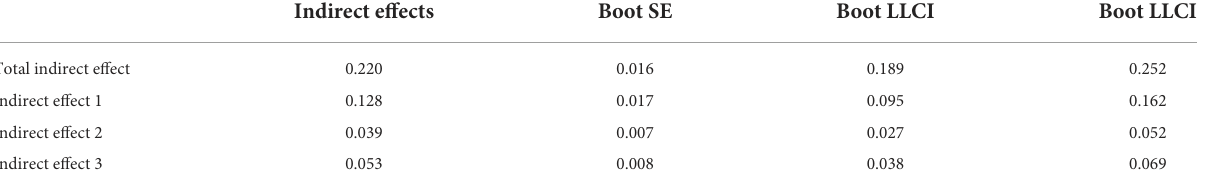
TABLE 3 Fear of COVID-19 and depression in the mediation effect analysis (N =